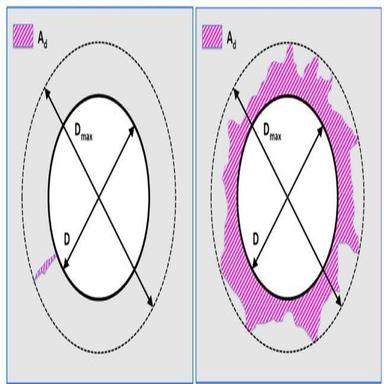
Example for identical delamination factor Fd, but a difference in the delaminated area Ad.